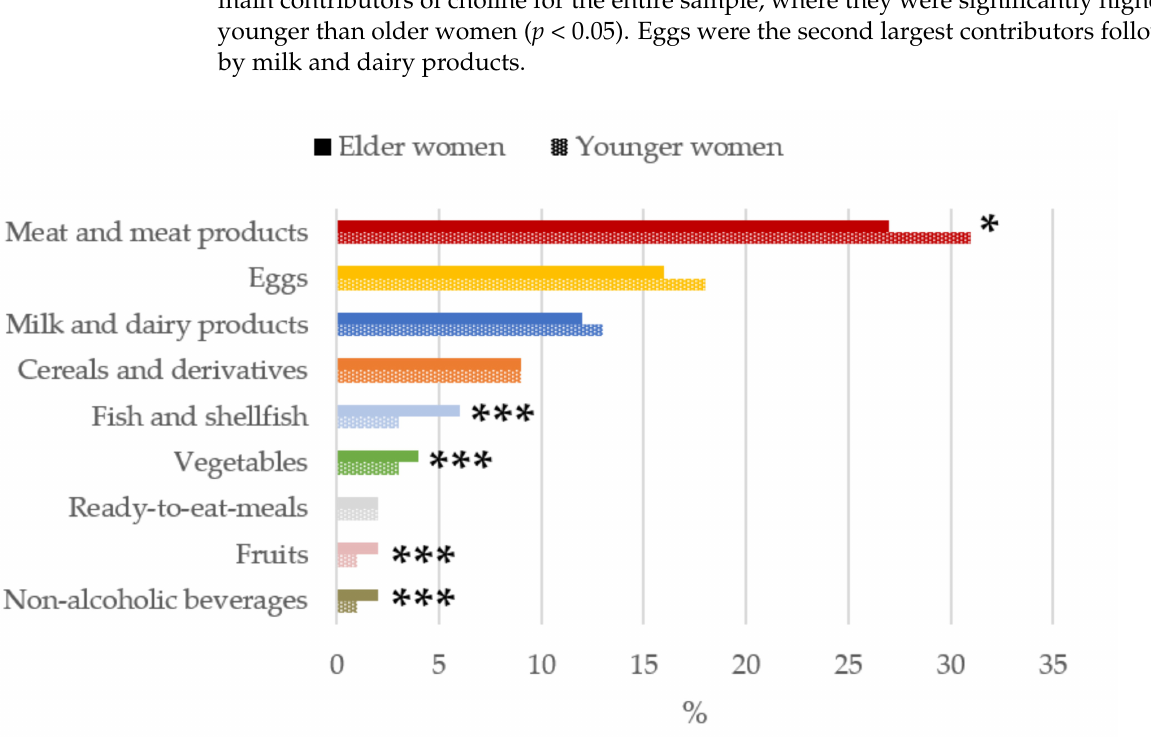
Figure 1. Contribution of main sources (food and beverages) to choline intake in women of childbearing age from the ANIBES study by age-group. * p < 0.05 difference vs. younger women (Mann–Whitney’s U test). *** p < 0.001 difference vs. younger women (Mann–Whitney’s U